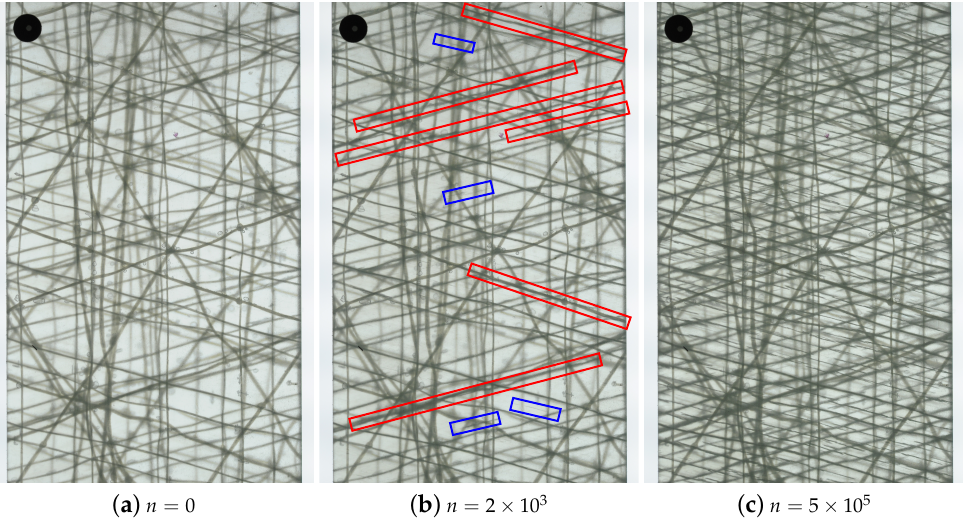
Figure 4. TWLI images of a [ 0/ + 75 2 /0/ − 75 2 ] s -laminate ( a ) at the very beginning of the test, ( b ) after n = 2 × 10 3 load cycles, and ( c ) at the end of the experiment after n = 5 × 10 5 cycles. In ( b ), cracks behind the bonding yarns are highlighted in red and subsequent cracks that are developing are highlighted in